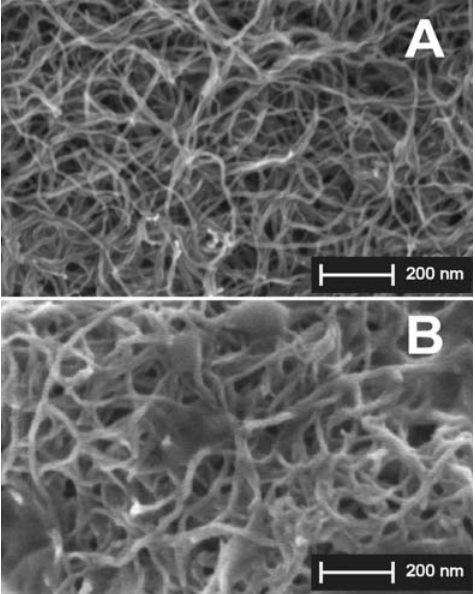
Figure 1. SEM images of graphite electrode after the drop-casting deposition of MWCNTs ( A ), and after the deposition of one layer ( B ) of a solution of cytochrome P4503A4. All images were acquired by using scanning electrode microscope in ultra-high resolution mode. Figure 1(A,B) was acquired with a 100,000× magnification.